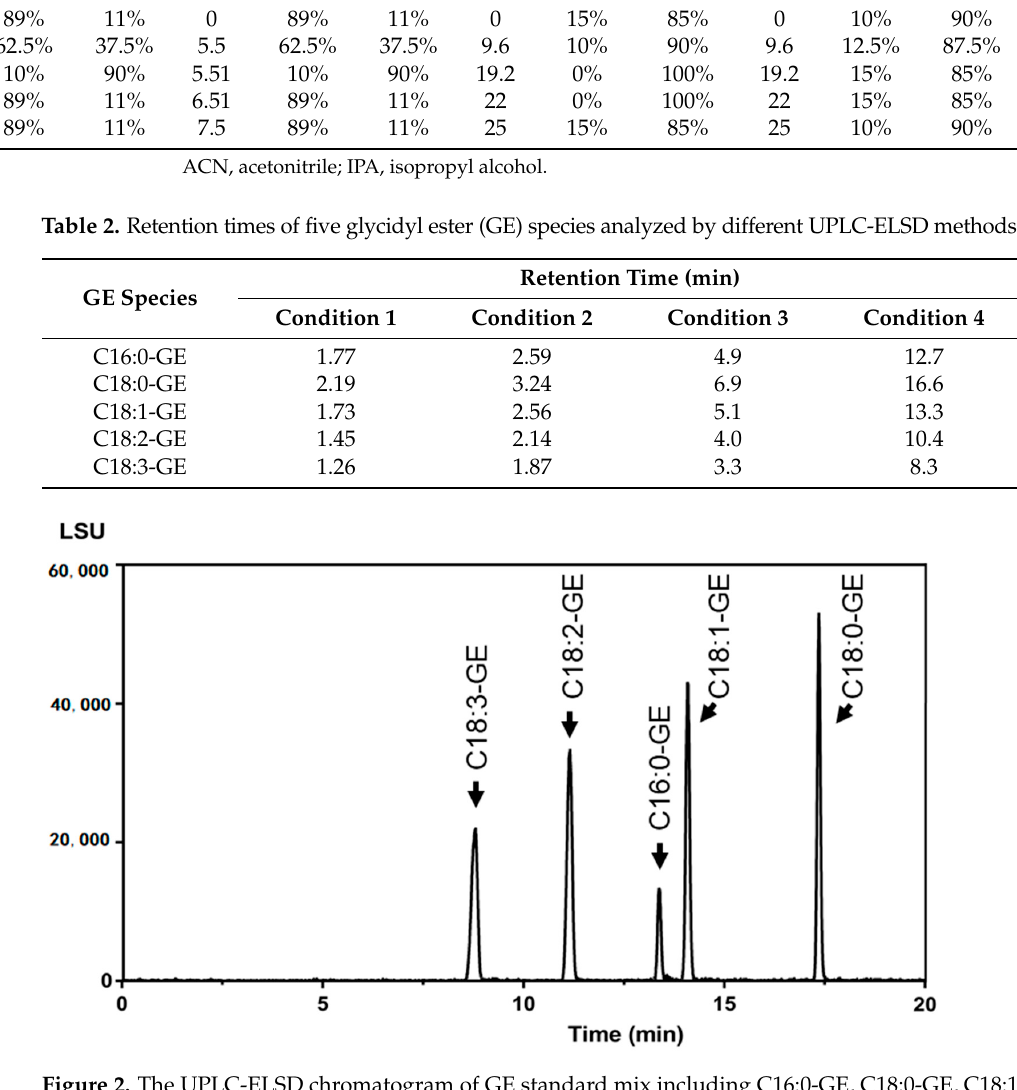
Figure 2. The UPLC-ELSD chromatogram of GE standard mix including C16:0-GE, C18:0-GE, C18:1-GE, C18:2-GE, and C18:3-GE.